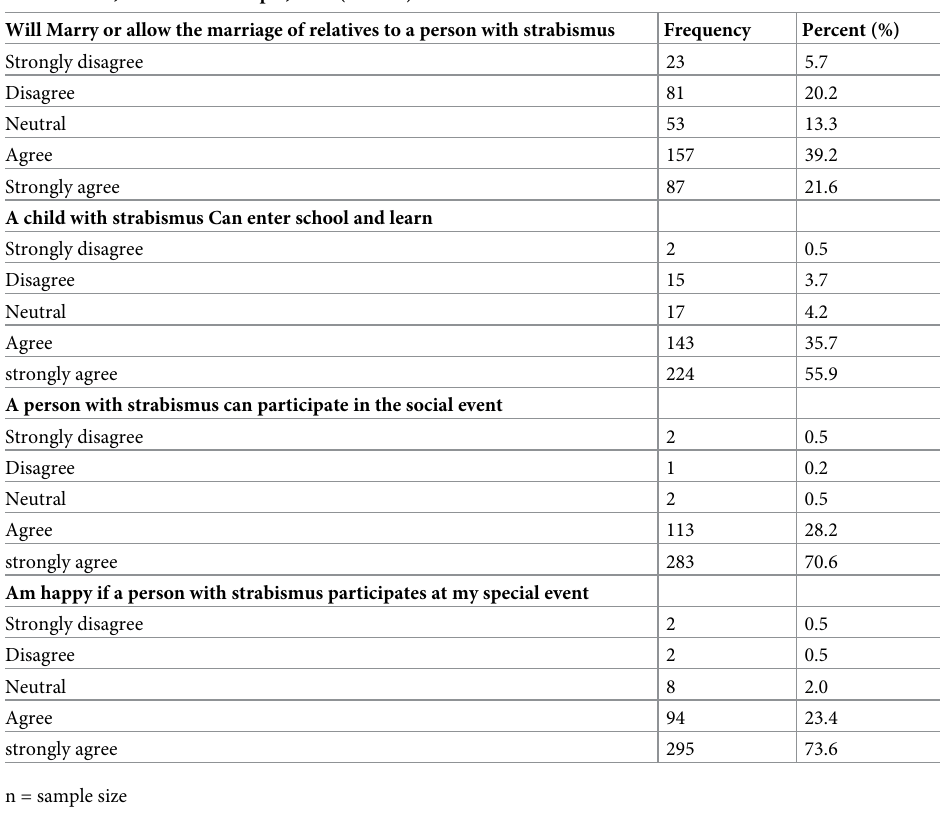
Table 3. Attitude of respondents towards cases of strabismus concerning marriage, education and social life in Woreta town, Northwest Ethiopia, 2020 (n = 403). Will Marry or allow the marriage of relatives to a person with